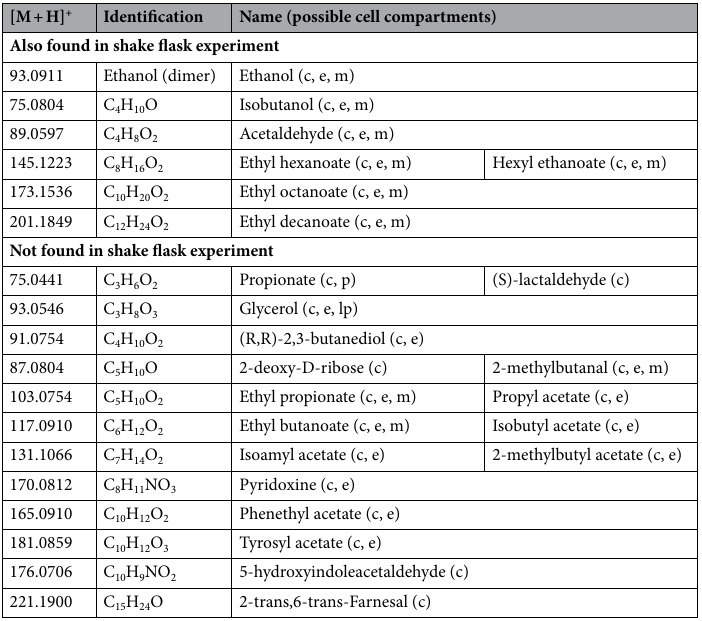
Table 2. Measured volatile metabolites that are also listed in the Yeast8 genome-scale model. Abbreviations for cell compartments: c (cytoplasm), e (extracellular), m (mitochondrion), n (nucleus), lp (lipid